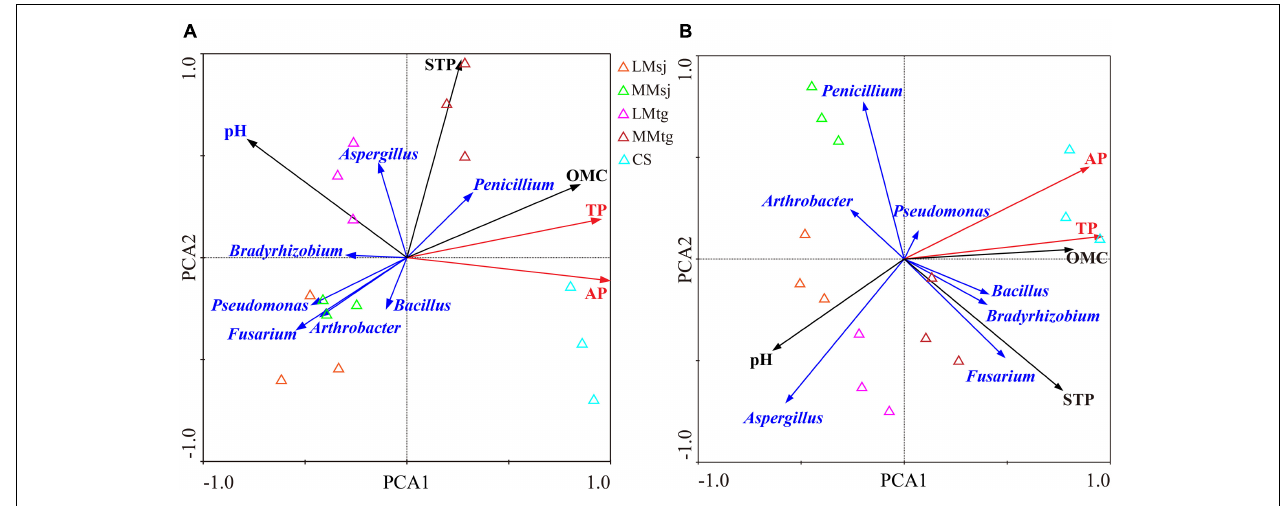
FIGURE 6 | The principal components analysis (PCA) of topsoil parameters related to phosphorus cycle (A) after DFAA/natural rainfall; (B) at the mature stage.